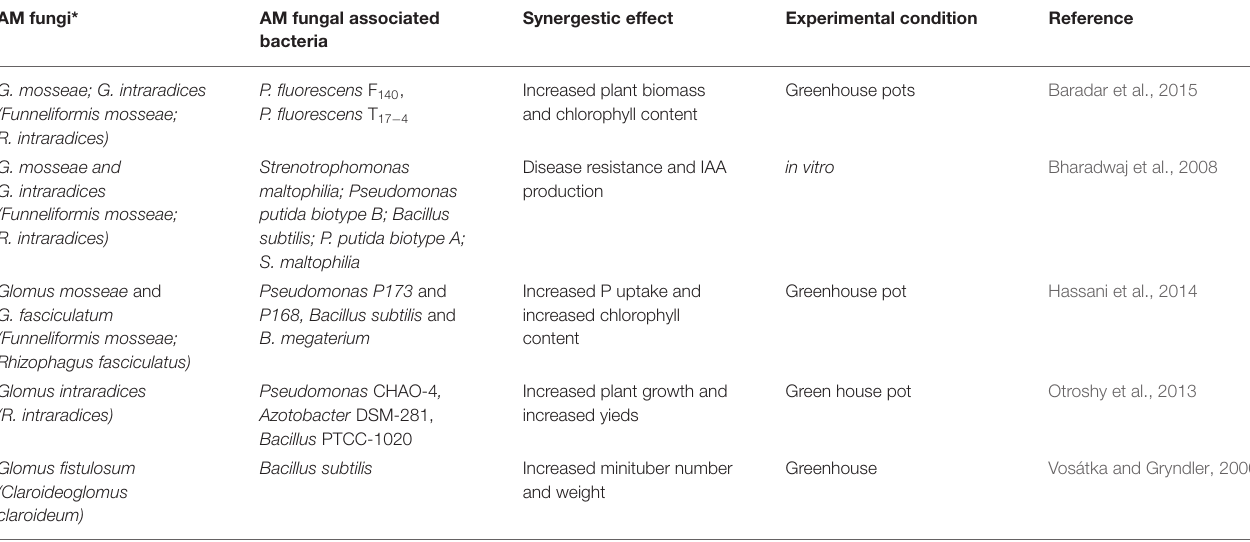
TABLE 2 | Summarized list of AM fungi and their associating bacteria in the potato soil